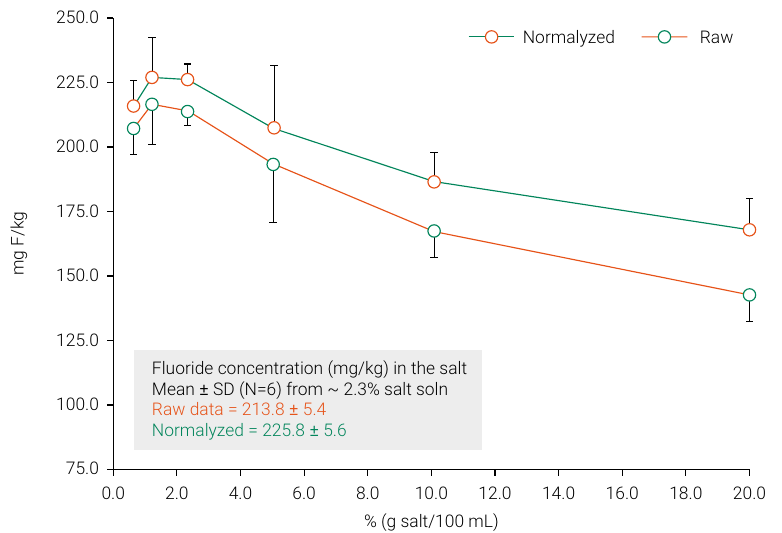
Figure 1. Concentration of fluoride found in salt (mg F/kg) according to the amount (g) of salt dissolved in 100 mL of purified water, determined from calibration curves made with standards fluoride solutions adjusted or not with p.a NaCL according to the % of salt in the